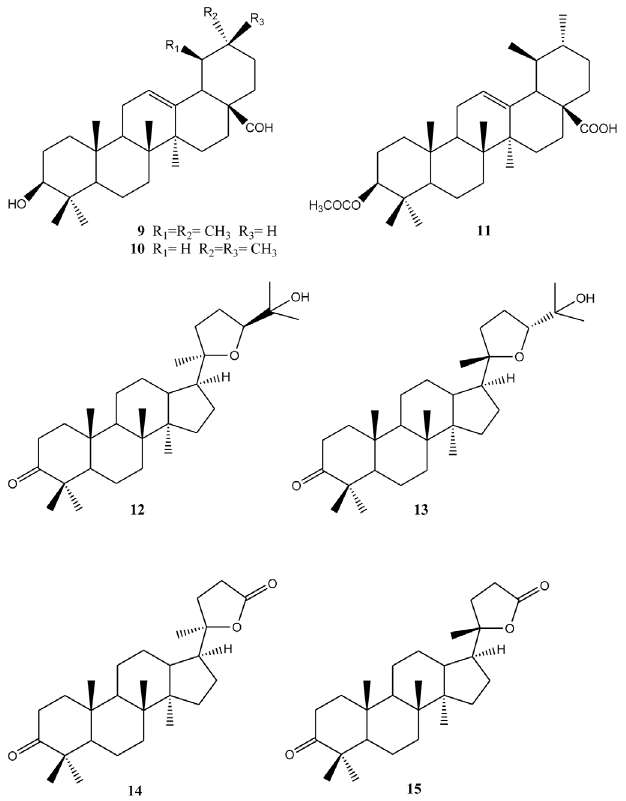
Fig 2. Compounds isolated from of Tetrigona melanoleuca propolis. 3- O -acetyl ursolic acid 11, dipterocarpol 5, ocotillone I 12, ocotillone II 13, and mixtures of ursolic and oleanolic aldehydes 9 – 10, and cabralealactones 14 – 15 were isolated from T . melanoleuca